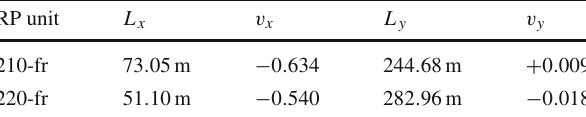
Table 1 Optical functions for elastic proton transport for the β ∗ = 2500m optics. The values refer to the left arm, for the right one they are very